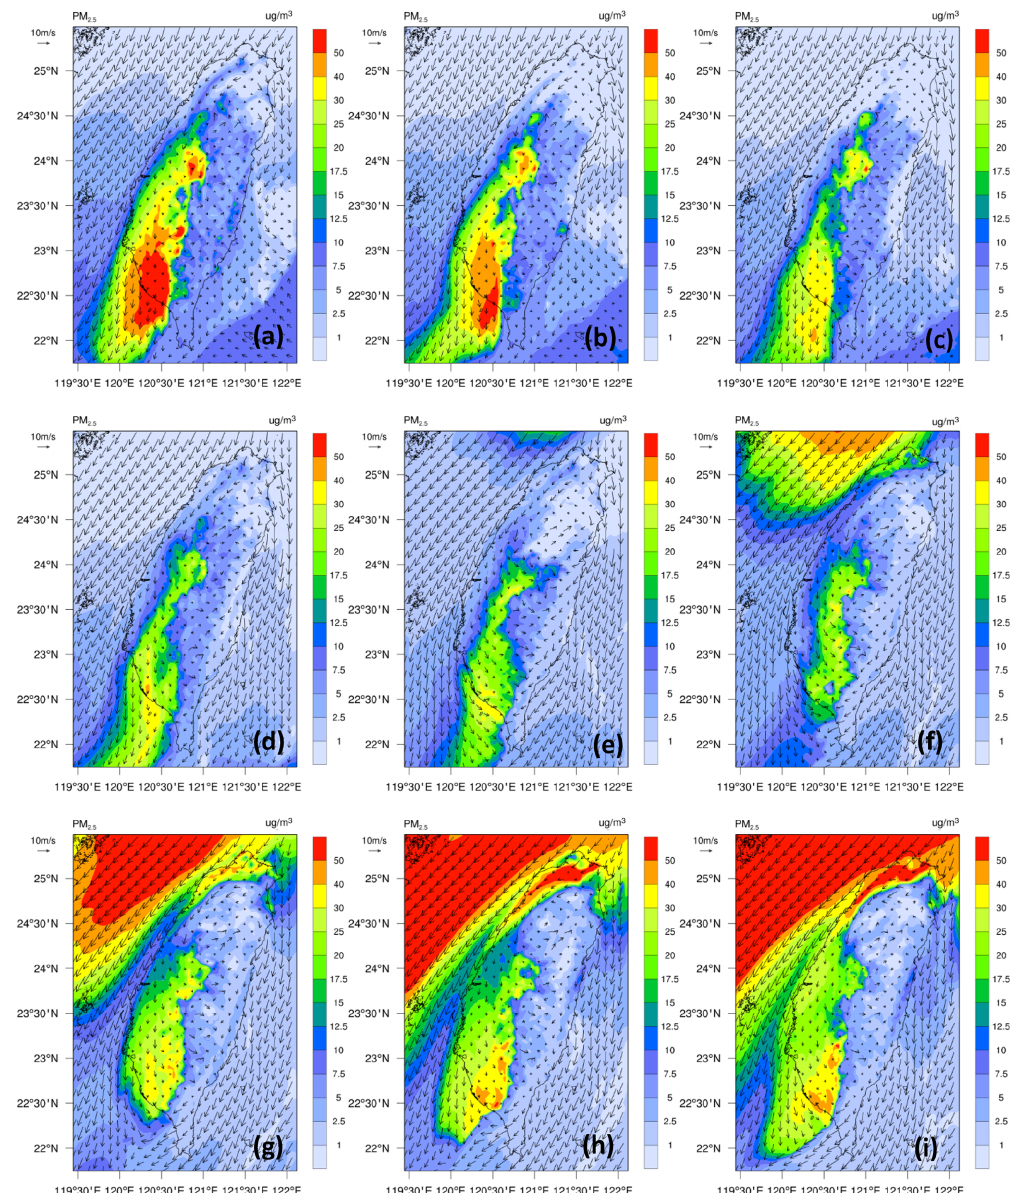
Figure 7. The 3h simulated wind vector and PM 2 . 5 distribution of the event at (a) 00:00LT, (b) 03:00LT, (c) 06:00LT, (d) 09:00LT, (e) 12:00LT, (f) 15:00LT, (g) 18:00LT, and (h) 21:00LT on 13 January and (i) 00:00LT on 14 January